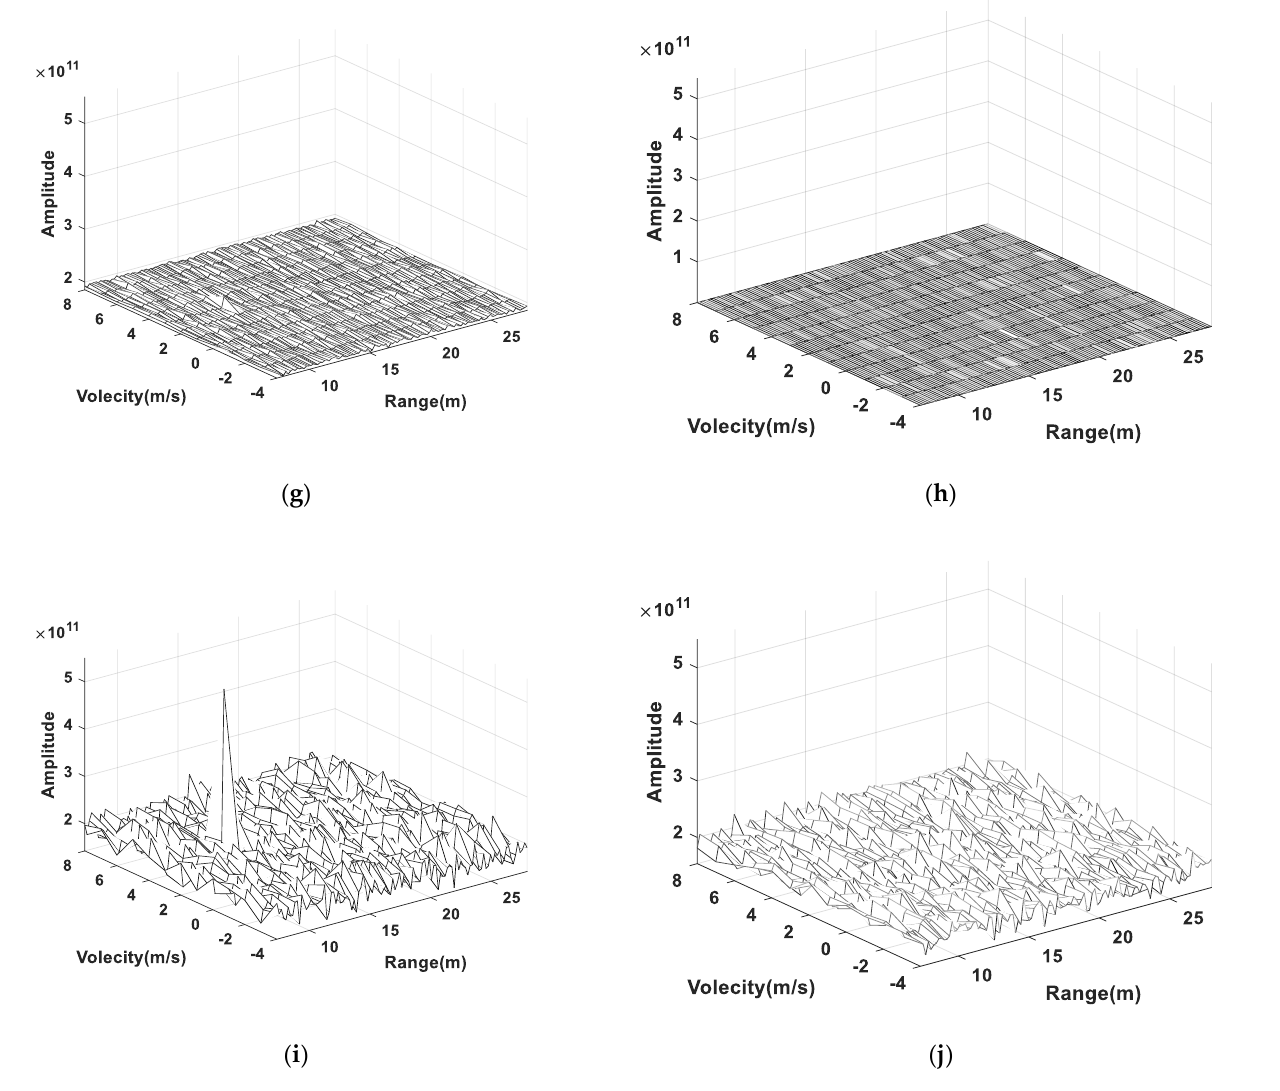
Figure 8. Processing results: ( a ) The detection scenario; ( b ) Measured data result after dechirping; ( c ) Measured data integration result via GRT; ( d ) Measured data integration result via GRFT; ( e ) Measured data integration result via the proposed method; ( f ) Measured data integration result via MTD-GRT; ( g ) Simulated data integration result via GRT; ( h ) Simulated data integration result via GRFT; ( i ) Simulated data integration result via the proposed method; ( j ) Simulated data integration result via MTD-GRT.